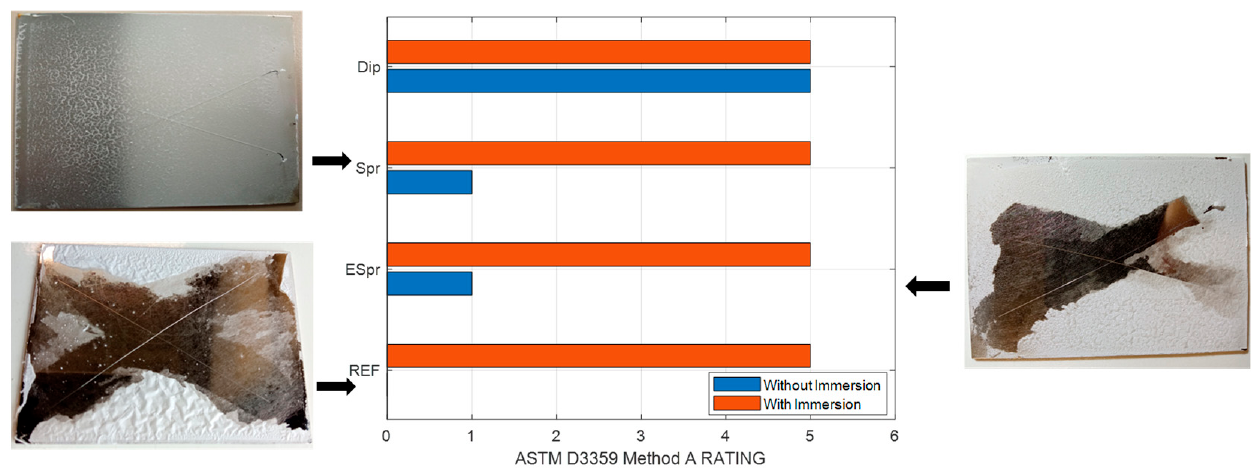
Figure 5. ASTM D3359 Method A Rating standardization adhesion results of functional coatings with and without distilled water immersion treatment. Assay picture results of Ref without immersion, ESpr without immersion, and Spr with immersion.